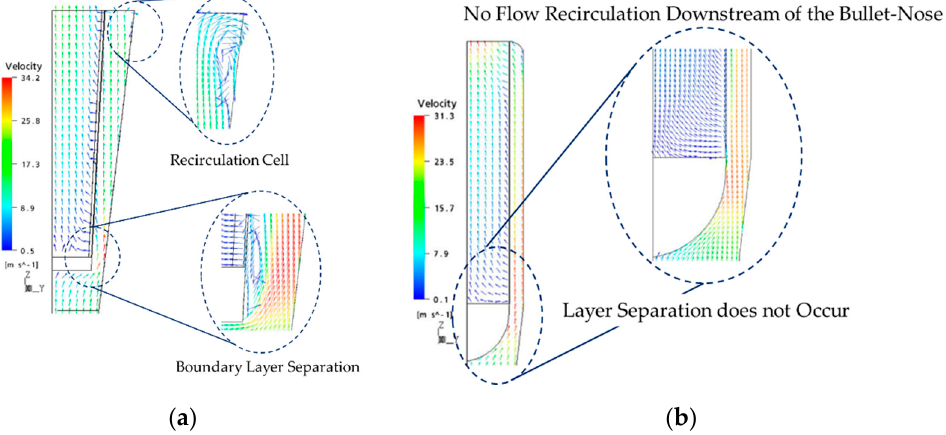
Figure 15. CFD for the velocity field plotted on the YZ-symmetric plane (x = 0) of ( a ) PCAR-1 a rectangular basket and perforate plates [2] and ( b ) PCAR-2 with a bullet nose and cylindrical basket [13].